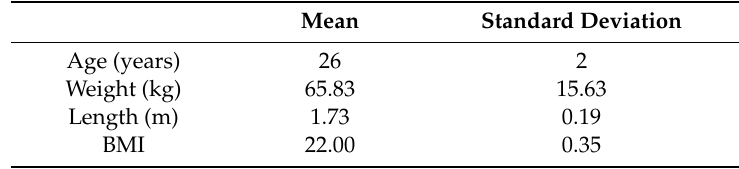
Table 1. Subject